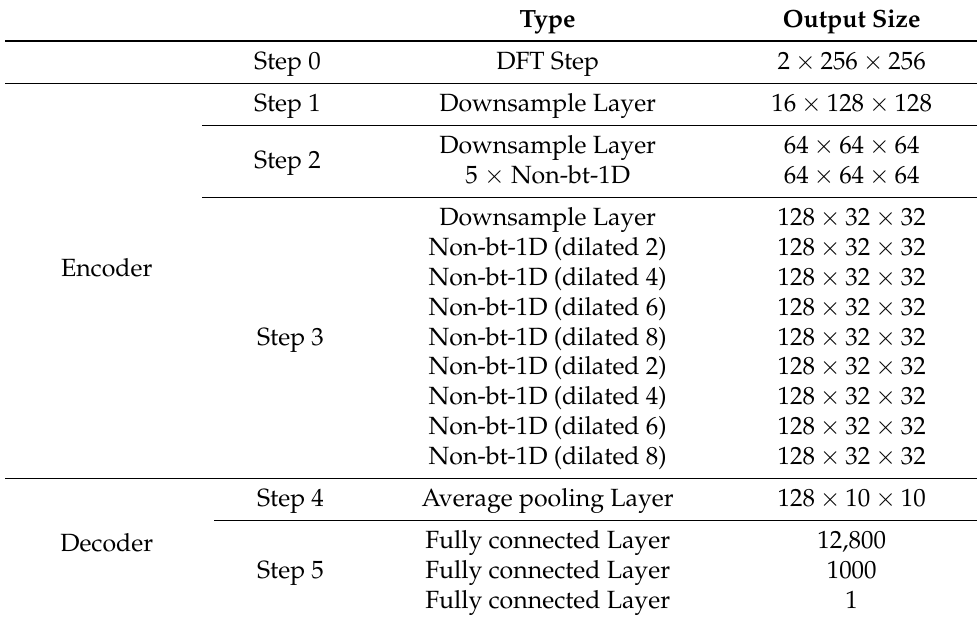
Table A1. Details of locating-path